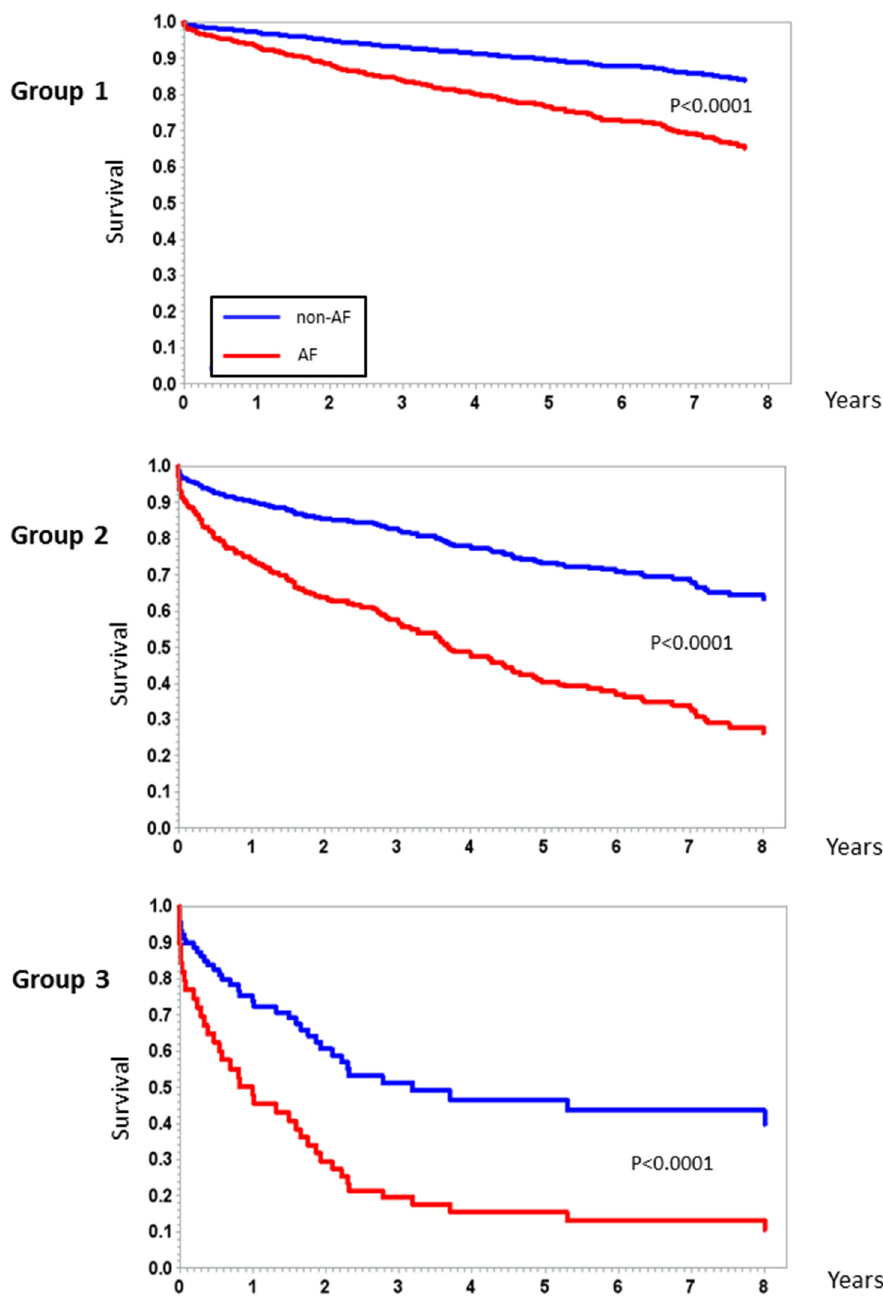
Figure 5. Kaplan–Meier curve analysis for long-term all-cause mortality stratified according to AF in the three study groups. p value by Log rank